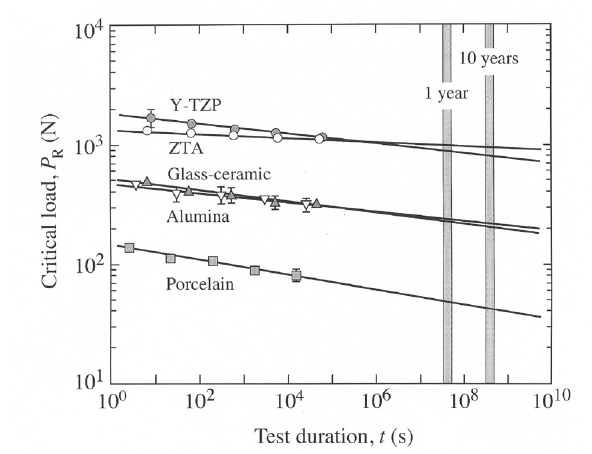
FIGURE 7 - Critical loads P for radial cracking in ceramic/ R polycarbonate bilayers as function of test duration t , for indentation with spheres. Data from constant loading rate tests. Slope of lines is a measure of susceptibility to slow FIGURE 8 - Examples of failed crowns: the upper is an In- crack growth. Critical loads diminish by a factor or two or Ceram crown while the lower is the monolithic ceramic, more over about a year| Dicor. (Courtesy of K.